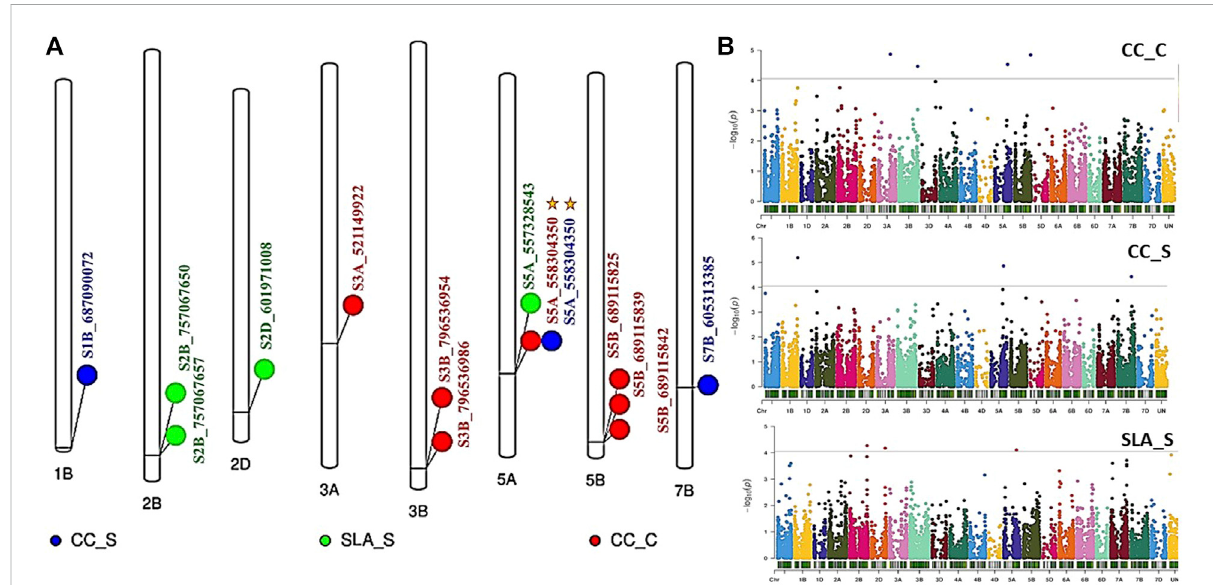
FIGURE 2 Correlationsoftheestimatedtraits,Chlorophyllcontent(CC), Canopy Temperature (CT), Speci fi c Leaf Area (SLA) in wheat under control and salinity. Red square = Correlations under Salinity stress, Blue square = correlations under control, Green square = Correlations under Salinity. C refers to control, while S refers to